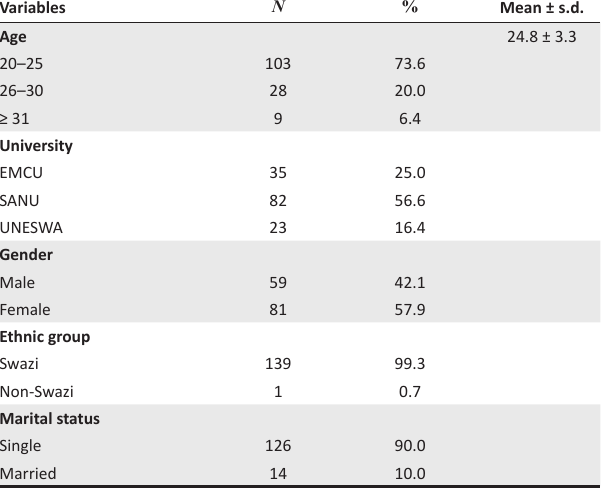
TABLE 2: Demographic characteristics of students ( n = 140). Variables